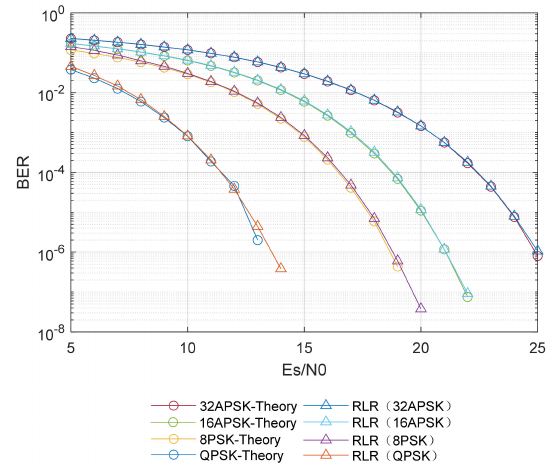
Figure 10. Simulation of BER curves of the proposed carrier synchronization